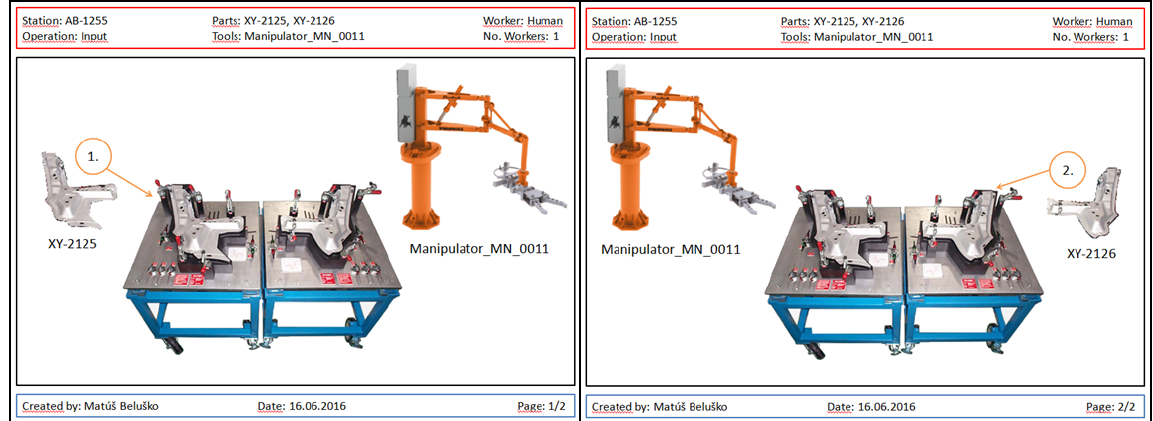
Figure 13: Final visual work instruction.